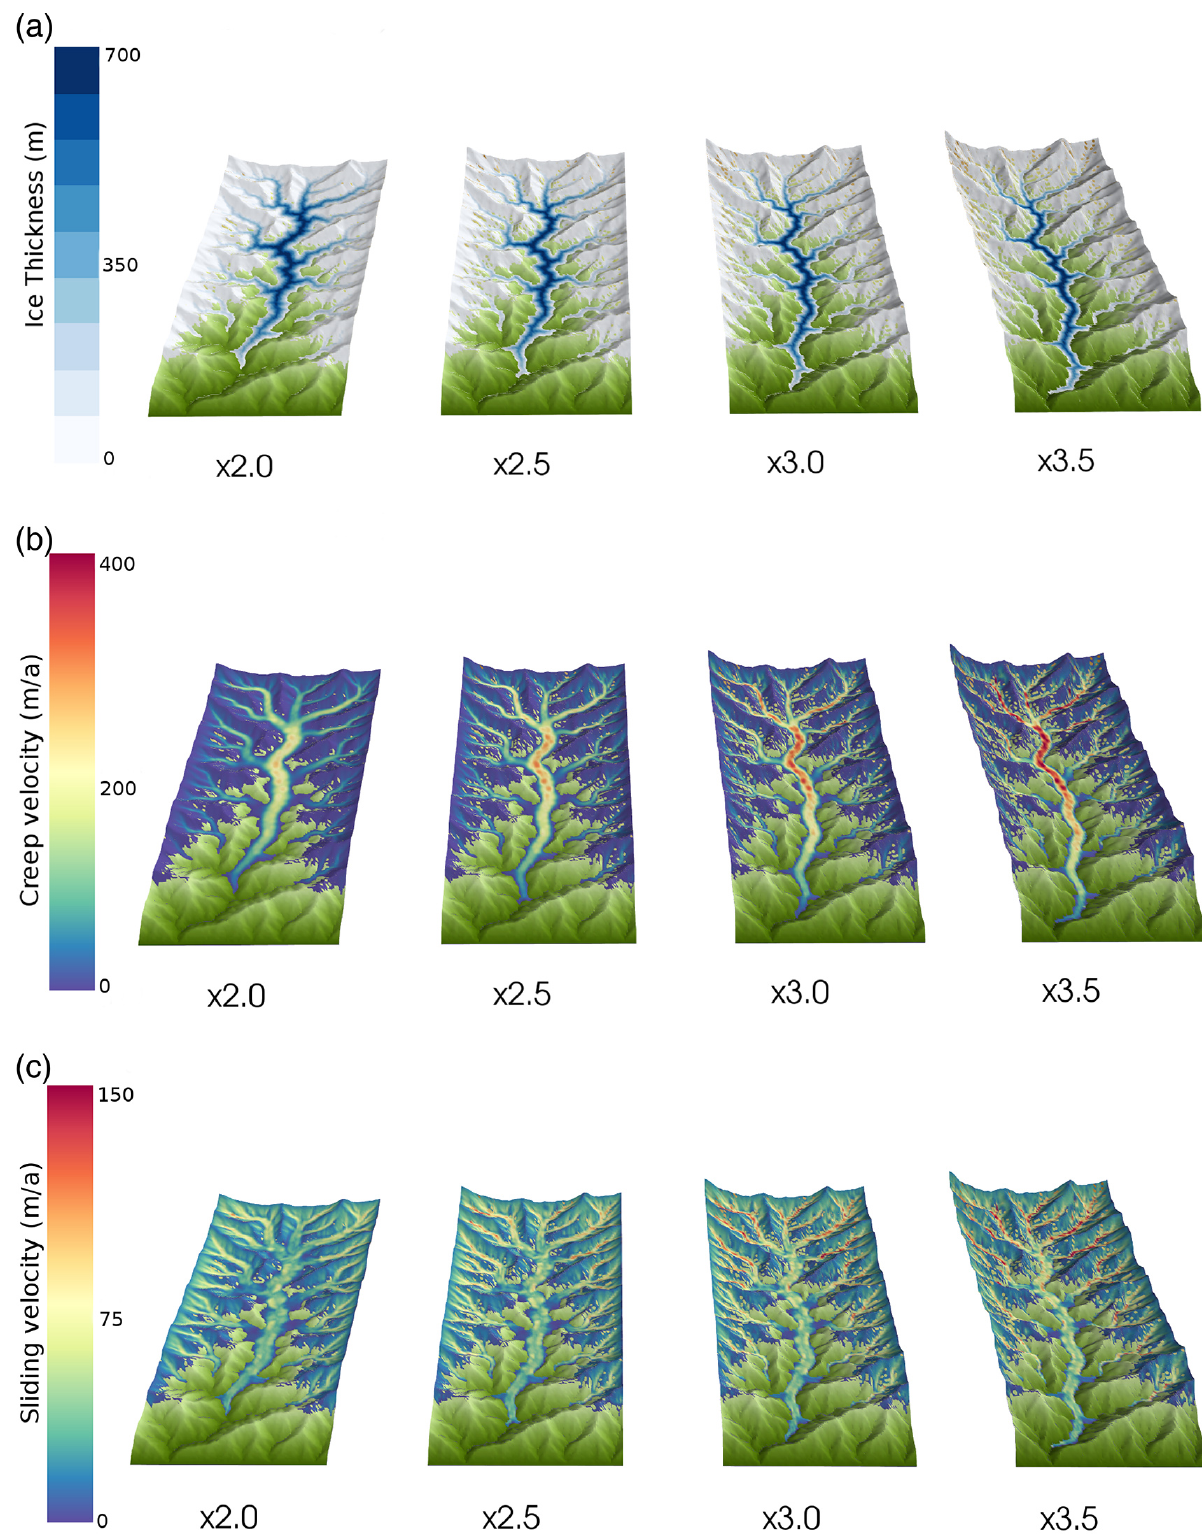
Figure 4. Bed topography with ice cover (a) , creep velocity (b) , and basal sliding velocity (c) computed at steady state using iSOSIA for the four scaling factors in experiment 2. The total relief is 3750, 5000, 6250, and 7500m